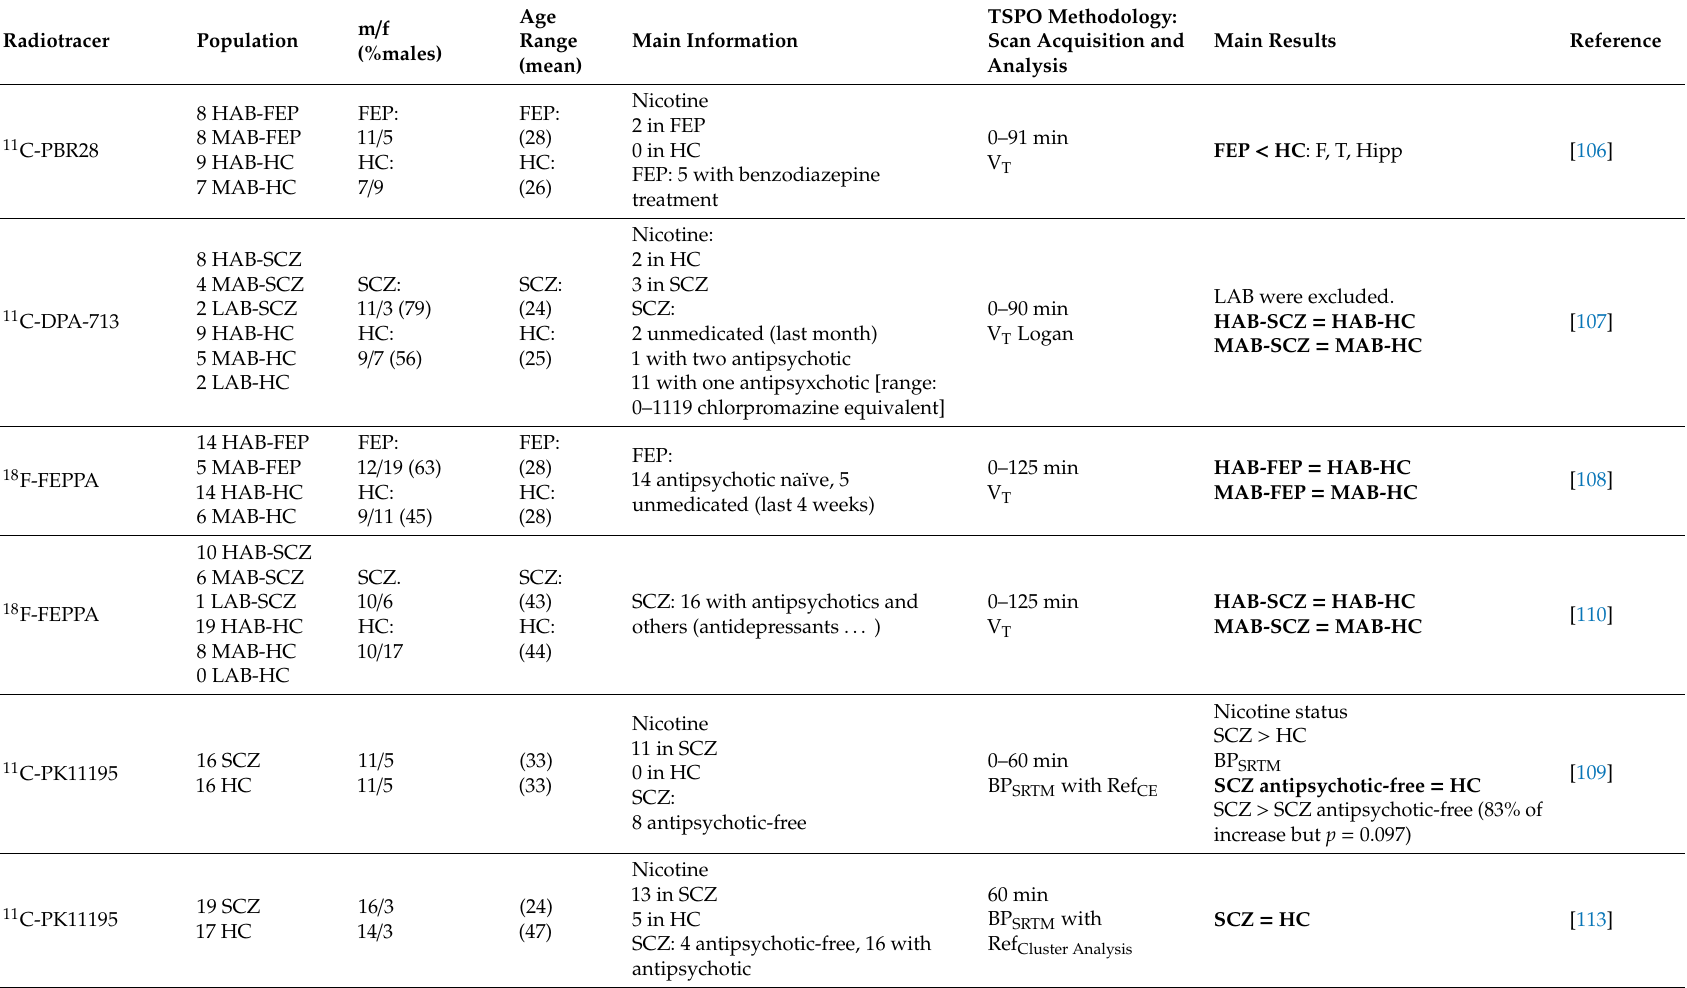
Table 2. Main results of TSPO PET / SPECT studies in